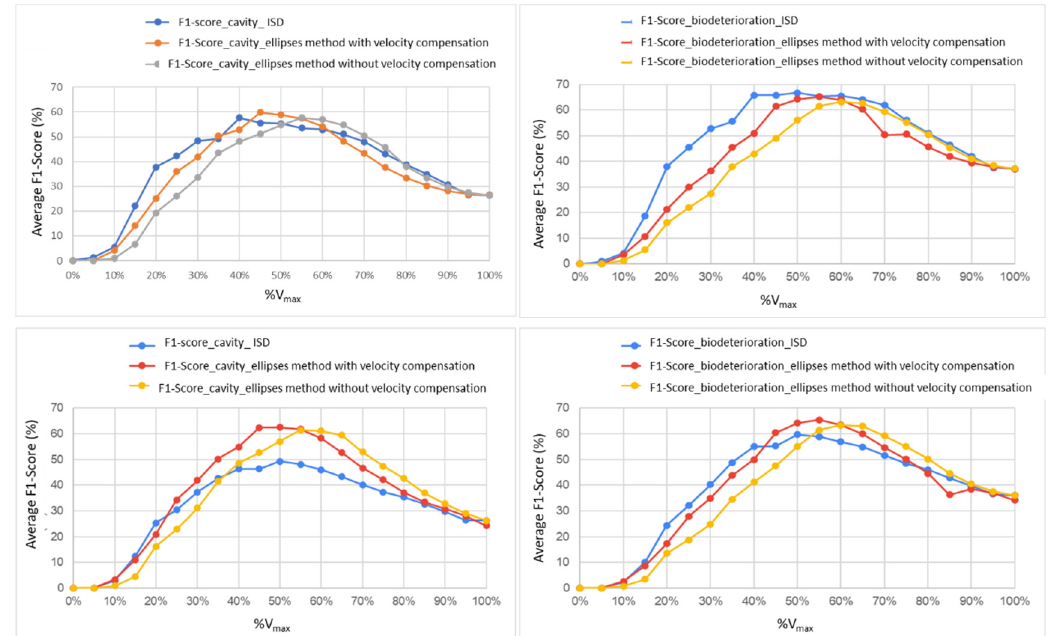
Figure 12. Behavior of the precision metric, obtained with the application of the confusion matrix for the cavity and the cavity plus biodeterioration as zones of interest, without the application of filters (upper graphs) and with the application of filters (lower graphs).